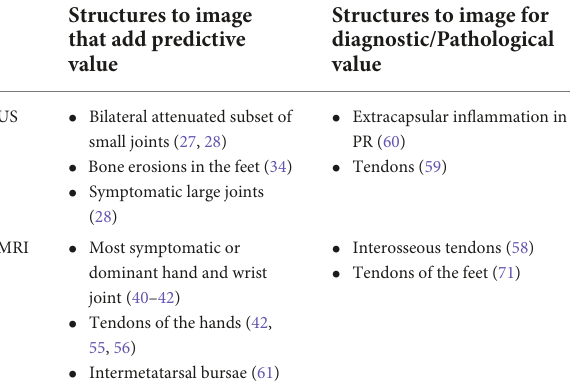
Structures to image for